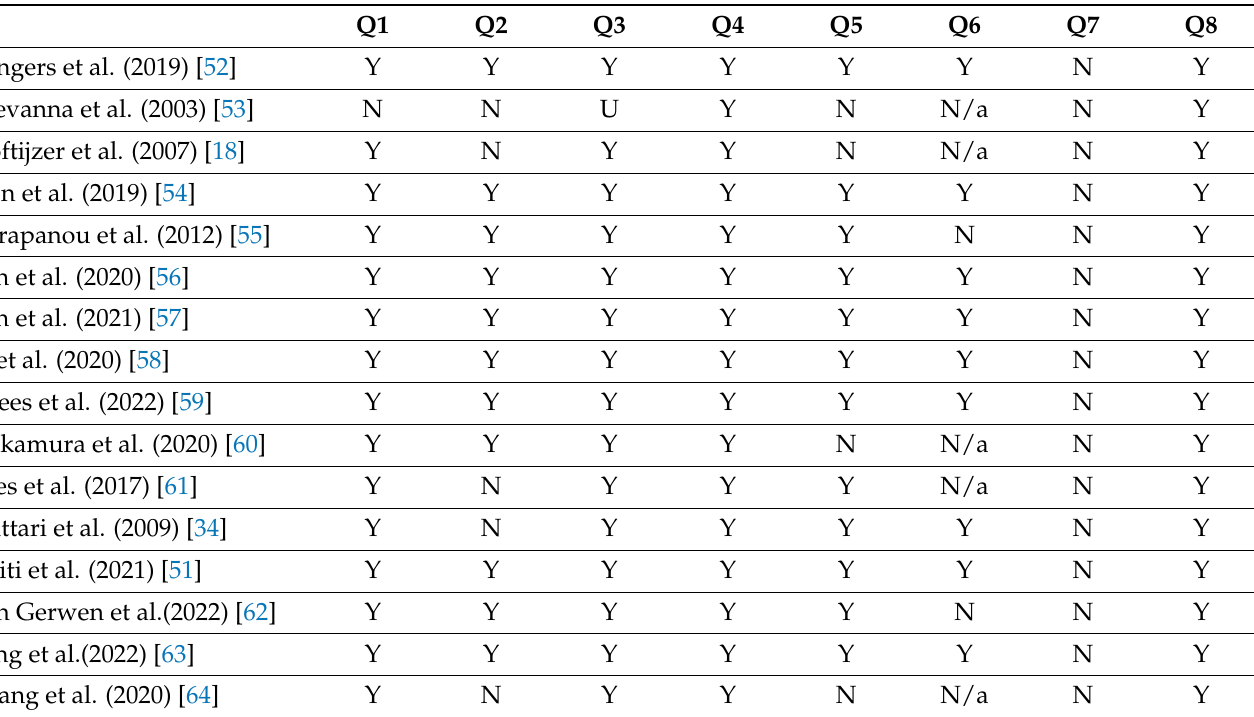
Table 2. Quality assessment of cross-sectional